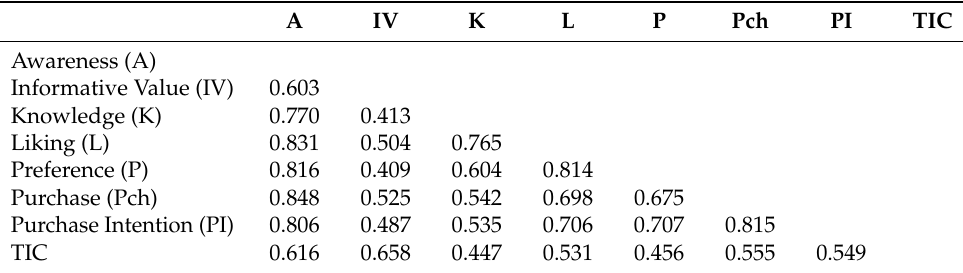
Table 4. Discriminant validity (HTMT a